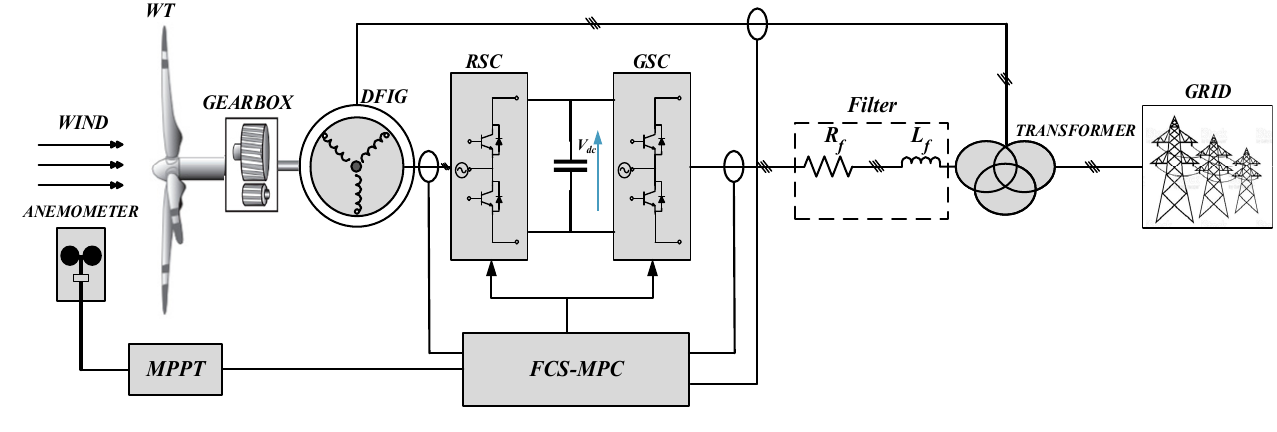
Figure 1. WECS with BTB